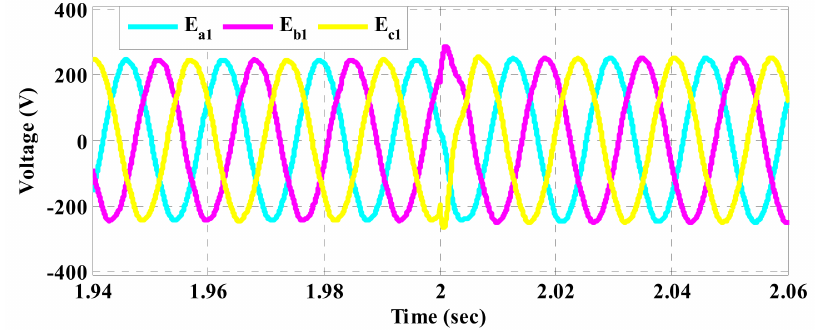
Figure 6. Load-side voltage waveforms of DG1 based on the proposed control strategy.